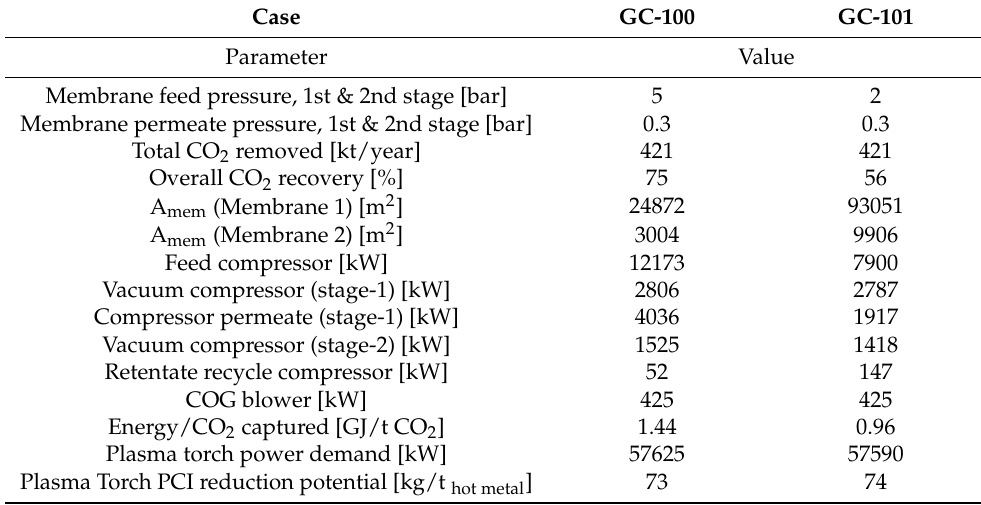
Table 6. Modelling results for two scenarios of CO 2 separation utilizing membrane technology.